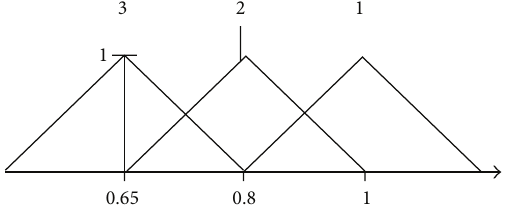
Figure 18: Quality value for sensor based upon inference engine